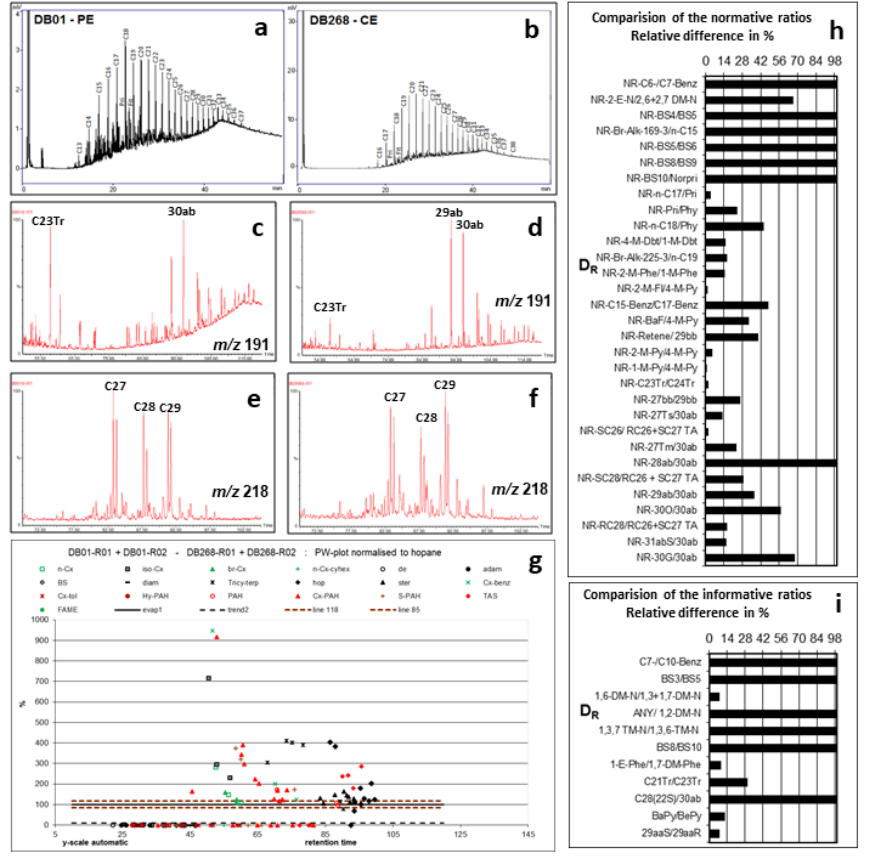
Figure 13. Combined results between samples